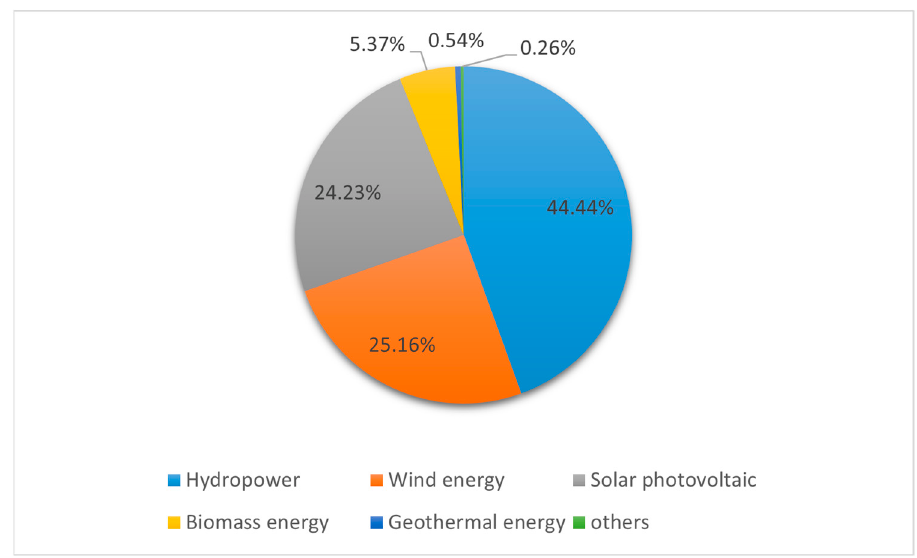
Figure 1. Electrical power generation by renewable energy source (RES)-based power plants.